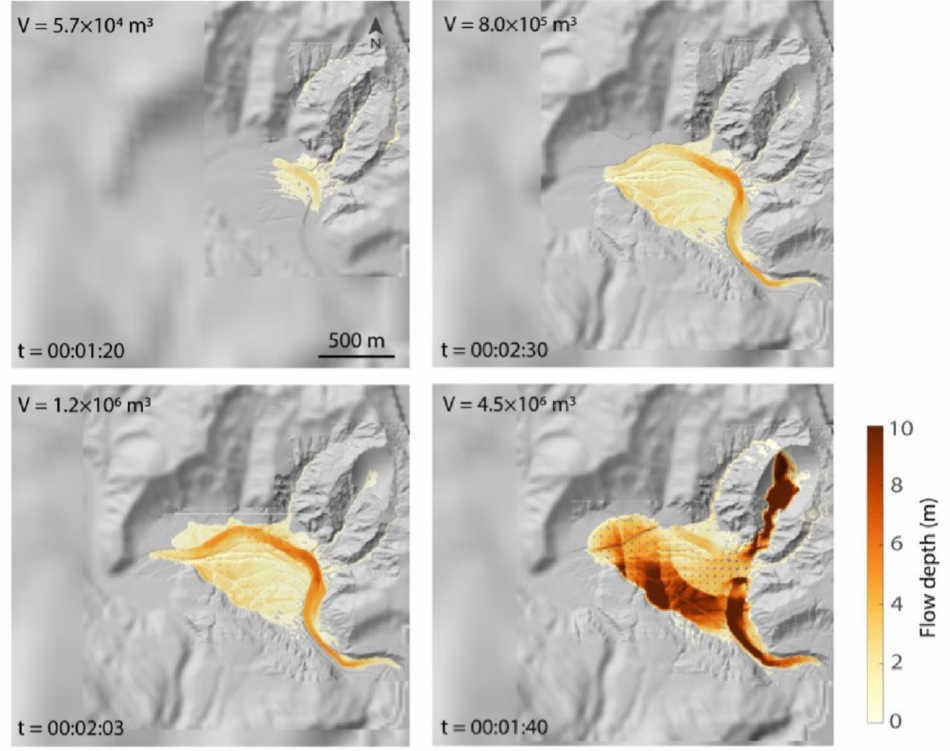
Figure 10. Maximum inundation zone of the campground as m 0 − m crit = − 0.02 meaning that landslide body is highly mobile ( m 0 and m crit are initial and critical solid volume fraction of sediment). V denotes volumes ranging from 5.7 × 10 4 to 4.5 × 10 6 m 3 , and t is timestamp